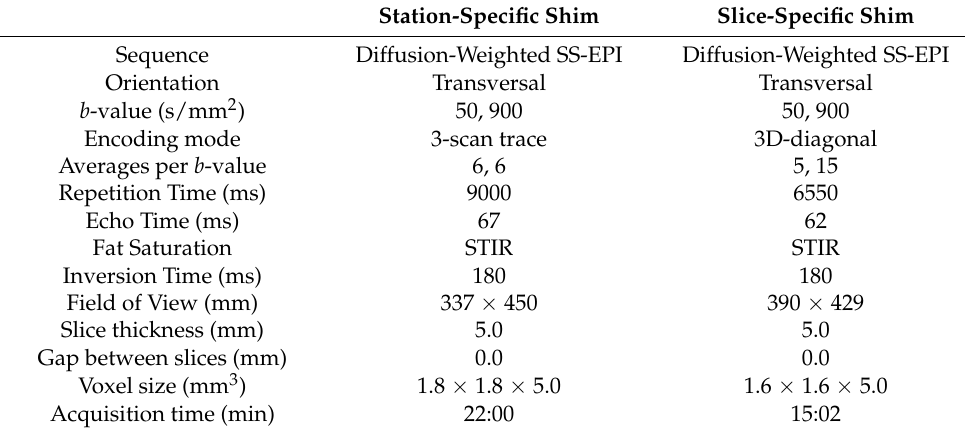
Table 1. Whole-body diffusion-weighted image acquisition